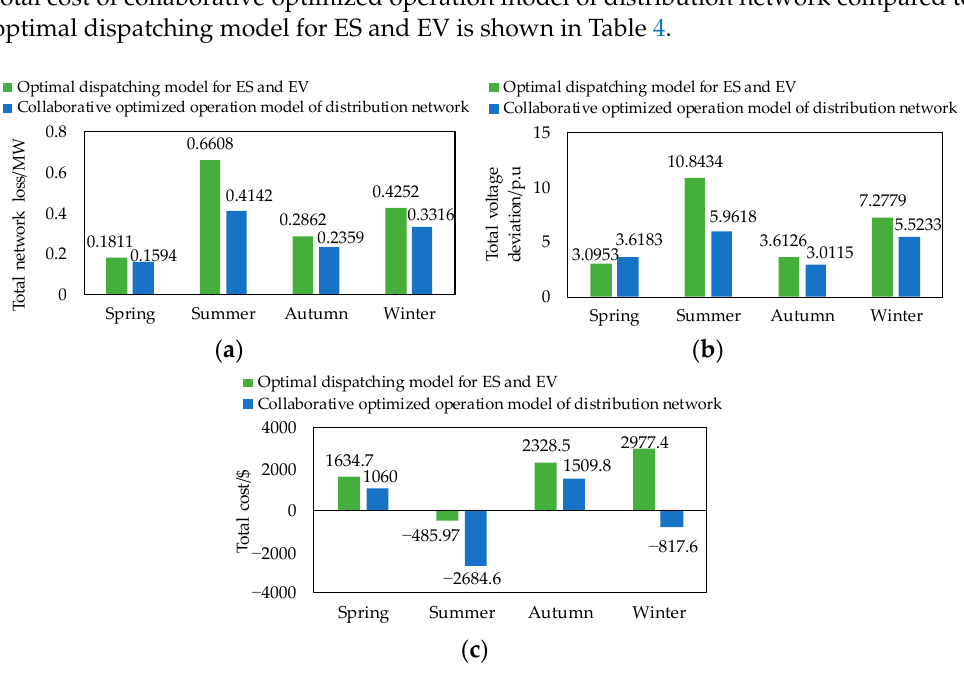
Figure 11. Comparison of results between optimized dispatching model and collaborative optimized operation model. ( a ) Total network loss. ( b ) Total voltage deviation. ( c ) Total cost. Table 4. The percentage of decrease in total network loss, voltage deviation, and total cost of collaborative optimized operation model of distribution network compared to optimal dispatching model for ES and